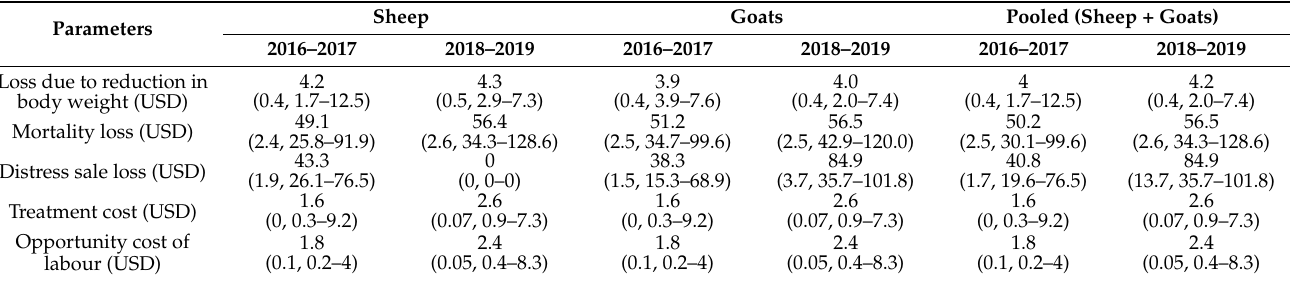
Table 3. Components of estimated loss (per animal) on the effects of PPR on sheep and goats in